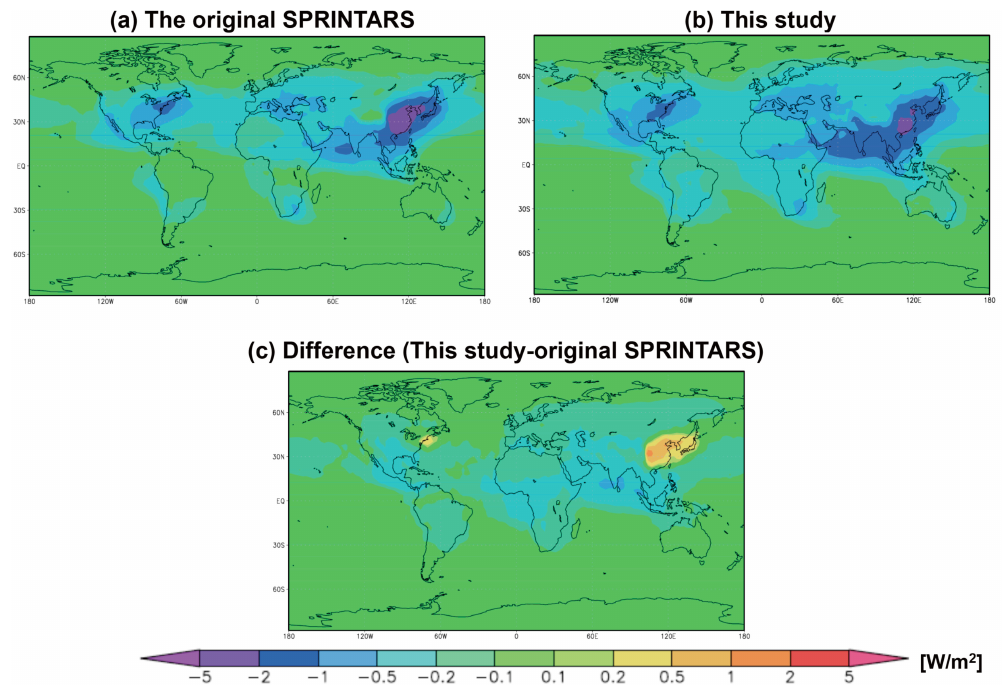
Fig. 12. Annual mean aerosol radiative forcings due to anthropogenic sulfate components in (a) OS, (b) NS, and (c) the difference between NS and